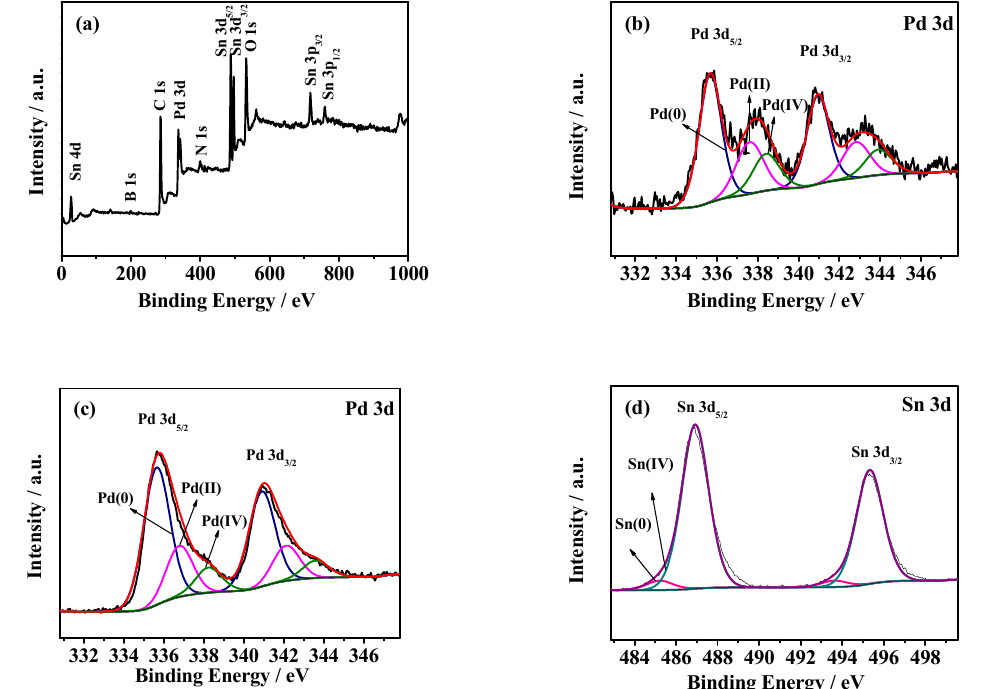
Figure 6. ( a ) XPS spectra of 3Pd1Sn/BN-G, Pd 3d region in 3Pd1Sn/G ( b ) and 3Pd1Sn/BN-G ( c ), ( d ) Sn 3d region in 3Pd1Sn/BN-G.